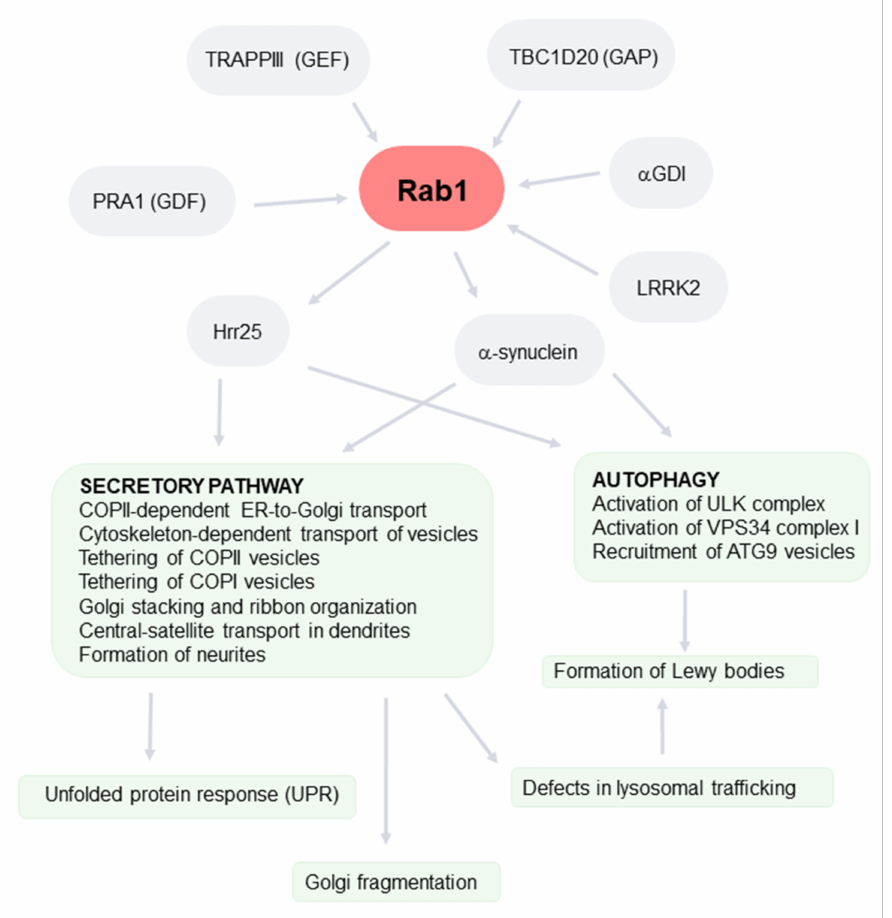
Figure 3. Overview of the roles and regulation of Rab1 and how it may be affected in PD. Activity and association with membranes of Rab1 are regulated by TRAPPIII (a guanine nucleotide exchange factor, GEF), TBC1D120 (a GTPase-activating protein, GAP), PRA1 (a GDI displacement factor, GDF), and α GDI (a GDP dissociation inhibitor, GDI). This activity is also regulated by the PD- related protein LRRK2. Rab1 regulates the early steps of the secretory pathway and autophagy through many effectors (see the full text for details). In addition, it regulates Hrr25, a member of the casein kinase 1 family, which also regulates these pathways. The expression of mutant forms of α -synuclein or overexpression of the wild type impair the secretory pathway, resulting in the activation of the UPR, the fragmentation of the Golgi ribbon, and the failure of the lysosomal route. These PD-associated alterations also affect autophagy. PD-related mutants of LRRK2 may enhance the activity of this GTPase, impairing secretory and autophagy pathways. Unbalanced secretory/autophagic/endolysosomal routes may lead to the formation of Lewy